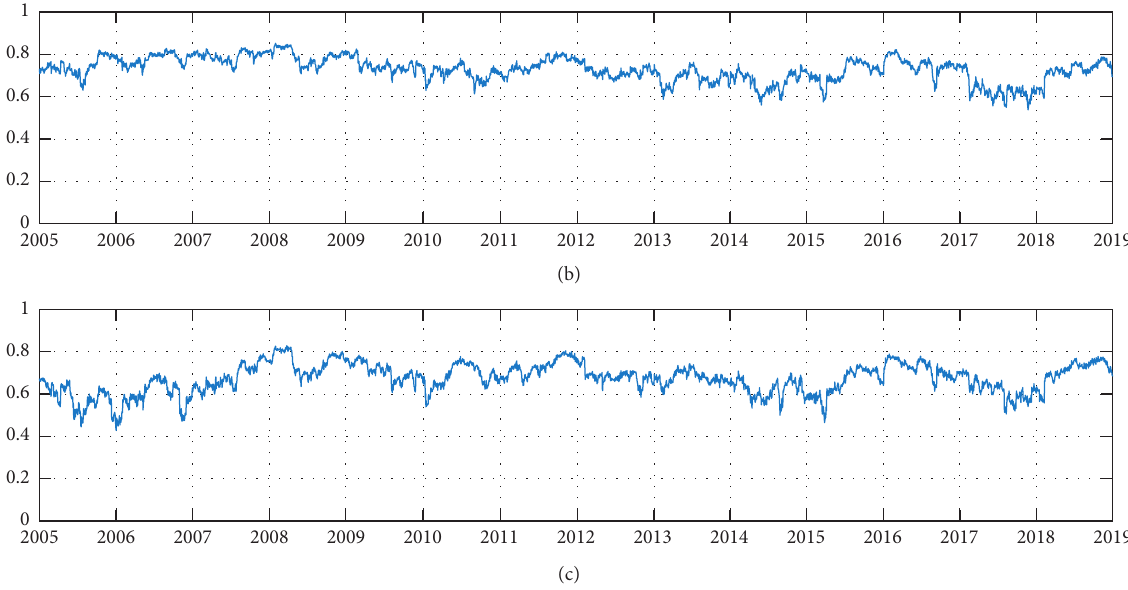
Figure 19: Kendall’s tau series of the multivariate DCC-NCCN copula model. (a) HSI-CEI. (b) HSI-CCI. (c)